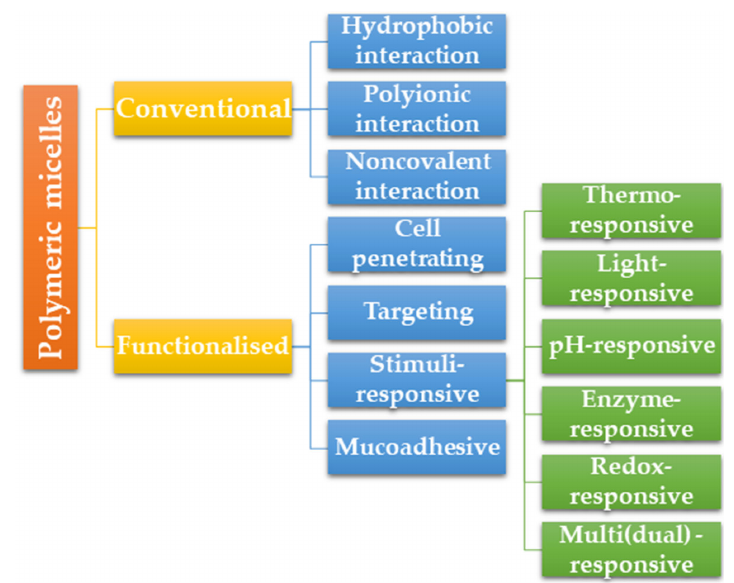
Figure 3. Types of polymeric micelles based on their functions.